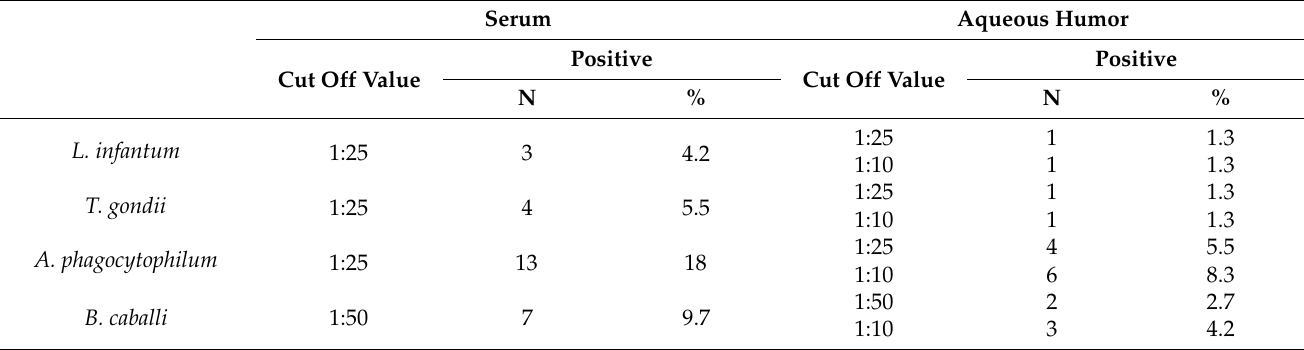
Table 1. Number and percentage of positive samples for antibodies against L. infantum , T. gondii , A. phagocytophilum and B. caballi in wild rabbits, in serum and in aqueous humor, with the same cut off value (1:25 or 1:50) and with a lower cut off value (1:10) in aqueous humor.